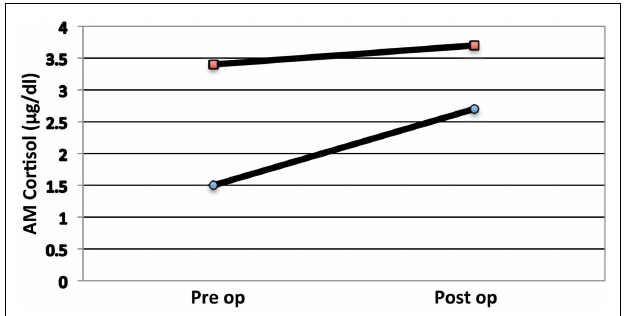
FIGURE 4 |AM serum cortisol levels of two patients with a low pre-op cortisol that, by choice, did not receive steroids. Note that both individuals had a poor cortisol response to